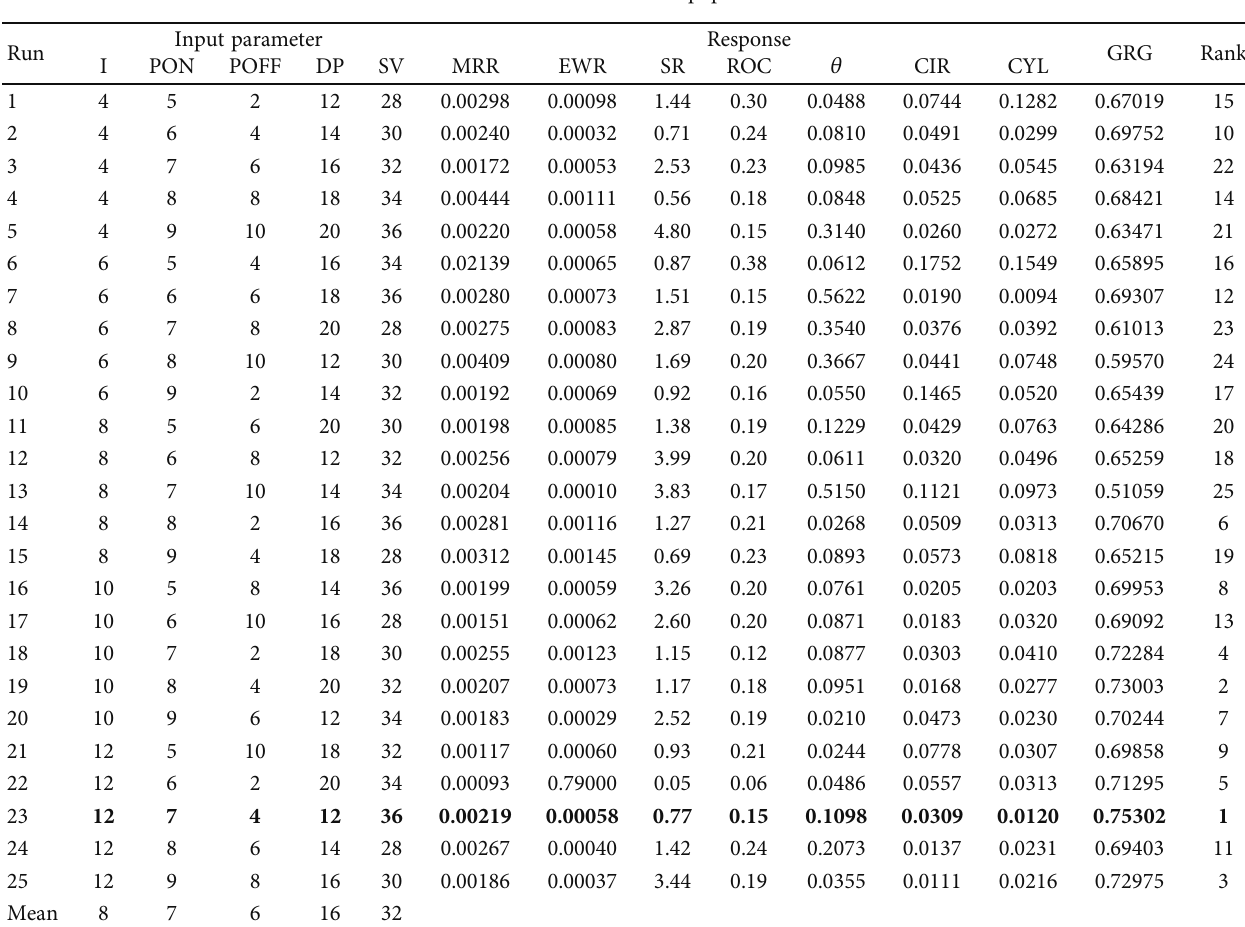
Table 8: Initial random